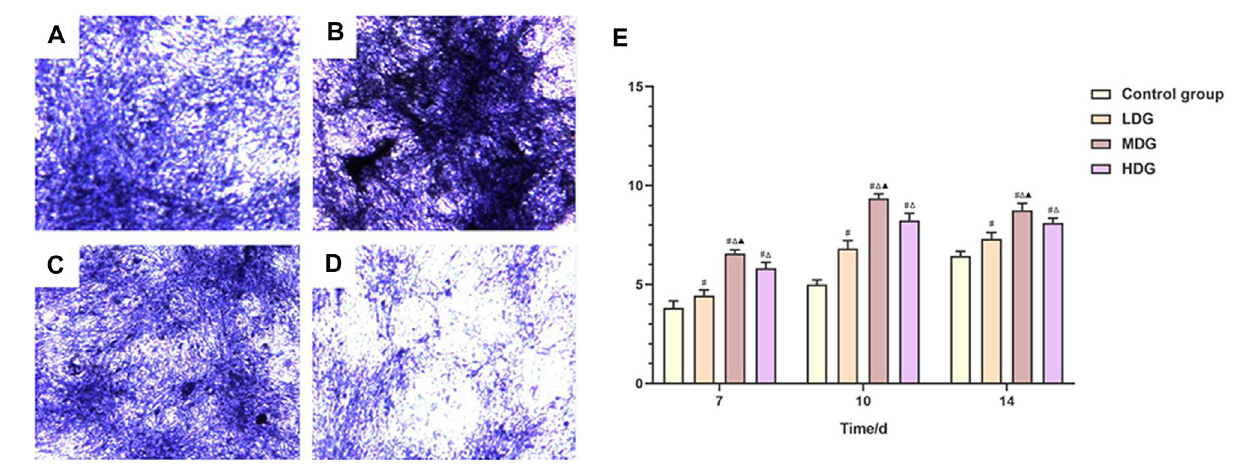
FIGURE 7 | The ALP staining assay is performed to evaluate ALP activity after incubated for 10 days (A) . TFDR low dosage group; (B) . TFDR medium dosage group; (C) . TFDR high dosage group; control group; (D) . control group (E) . The ALP activity at each time point of the control group, TFDR low dosage group, TFDR medium dosage group, and TFDR high dosage group. The data are expressed as the mean ± SEM of three independent experiments. # p < 0.05 vs. control group, Δ p < 0.05 vs. TFDR low dosage group, ▲ p < 0.05 vs. TFDR high dosage group.